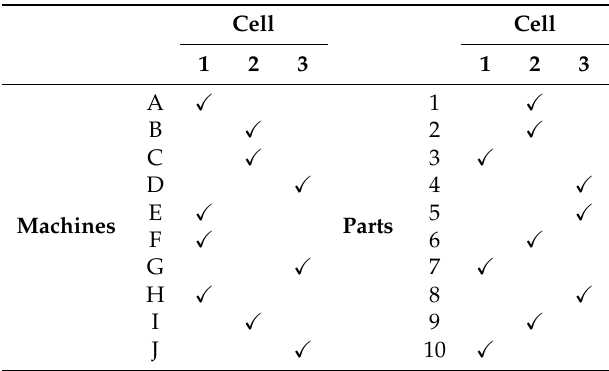
Table 2. Problem example. Randomly generated machine-cell and part-cell matrices.